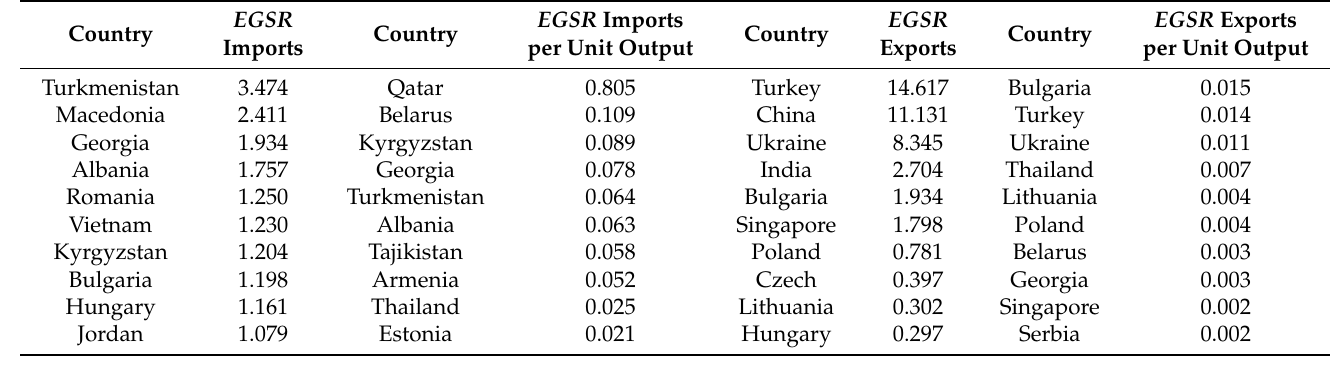
Table 1. Top 10 countries of EGSR imports/exports, EGSR imports/exports per unit output. Unit of EGSR imports/exports: million dollars.